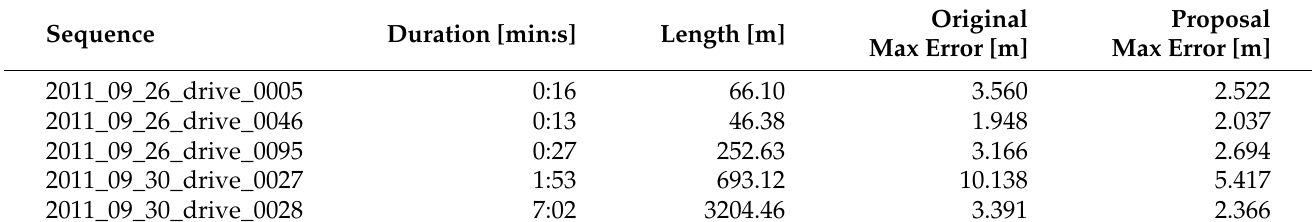
Table 3. The maximum error among any KITTI sequence. Original is our previous work adapted with permission from ref. [28]. Copyright 2015 Copyright IEEE, without any building component, Proposal is this